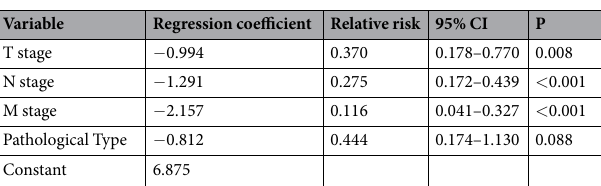
Table 2. LR on survival time > 6